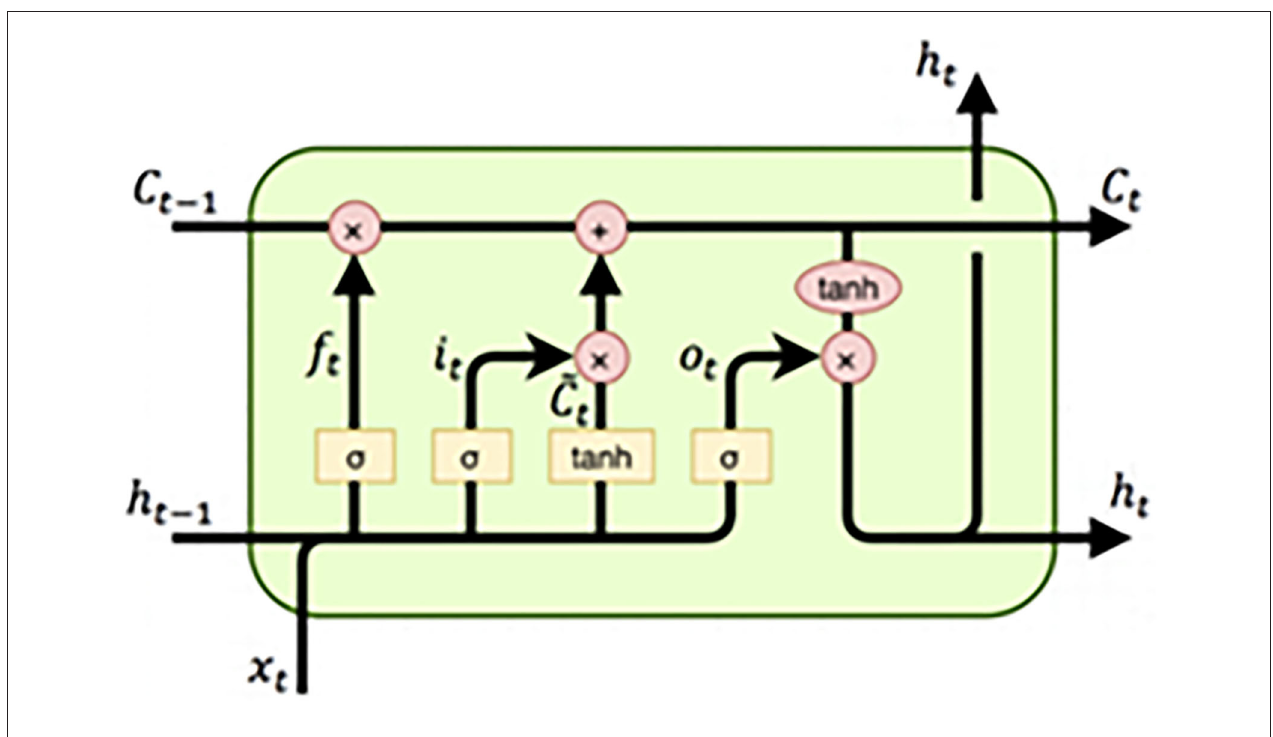
FIGURE 1 | The structure of the LSTM.